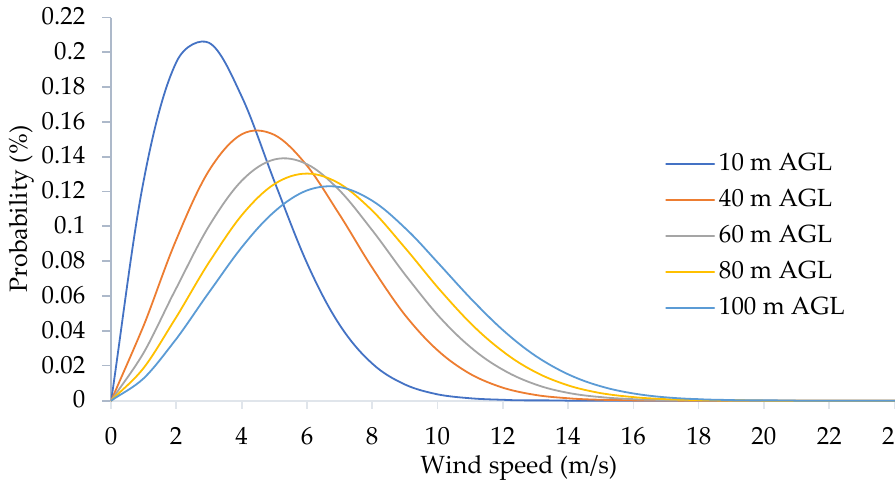
Figure 4. The Weibull probability distribution for the Charfashion site at different wind shear val- ues.